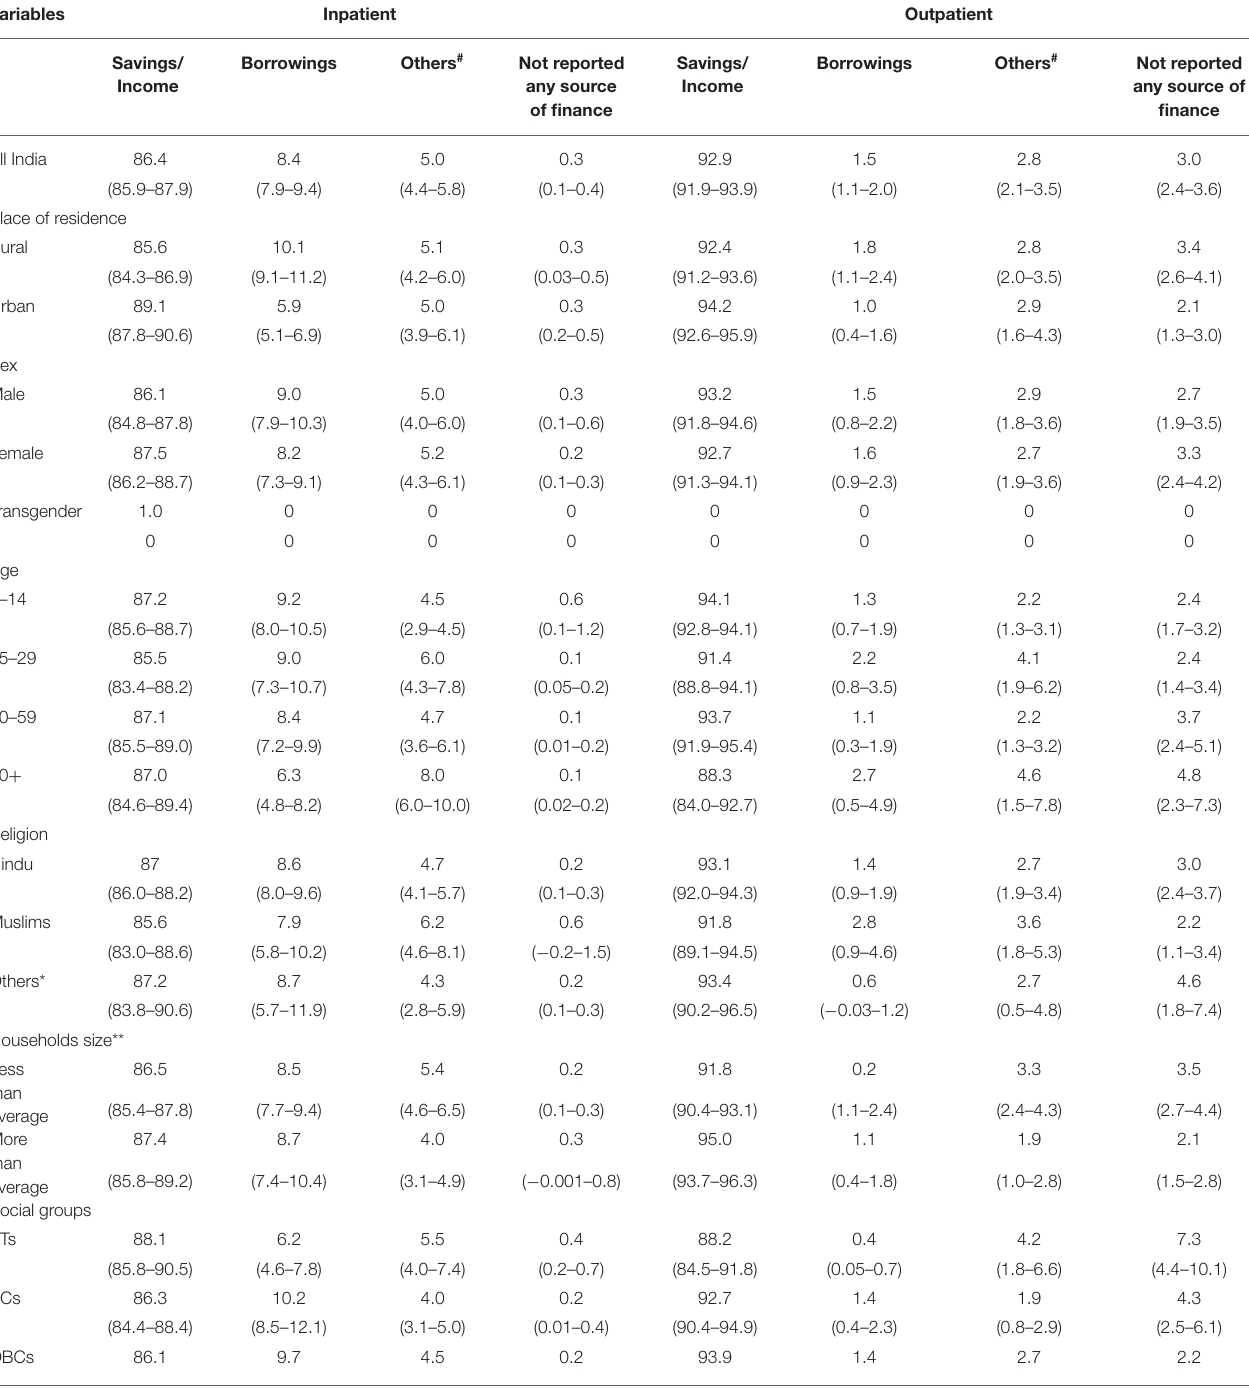
TABLE 4 | Socio-economic and demographic covariates in the source of finance to cope with out-of-pocket (OOP) expenditure on infectious diseases in India (2017–18).